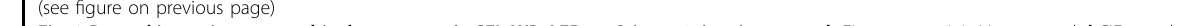
Fig. 8 Perovskite emitters as multicolour centres in SEL-WPeLEDs. a Schematic band structure, b EL spectra, c J – L – V curve, and d CIE coordinate of CsPbBr x Cl 3 − x nanocrystal and MEH:PPV-blend white LED. Reprinted with permission from ref. 83 . Copyright 2017 WILEY-VCH Verlag GmbH & Co. KGaA, Weinheim. e Device architecture of the SEL – WPeLED. f, g Secondary-electron (SE) image and cathodoluminescence (CL) spectra of the BCPX fi lm acquired at 5.0 keV. h EL spectra at different driving voltages (inset: photograph of a working device). Reprinted with permission from ref. 87